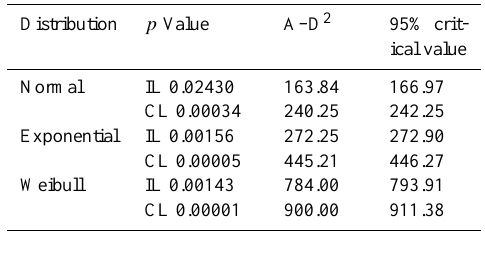
Table 4. Anderson–Darling statistics for normal, exponential and Weibull